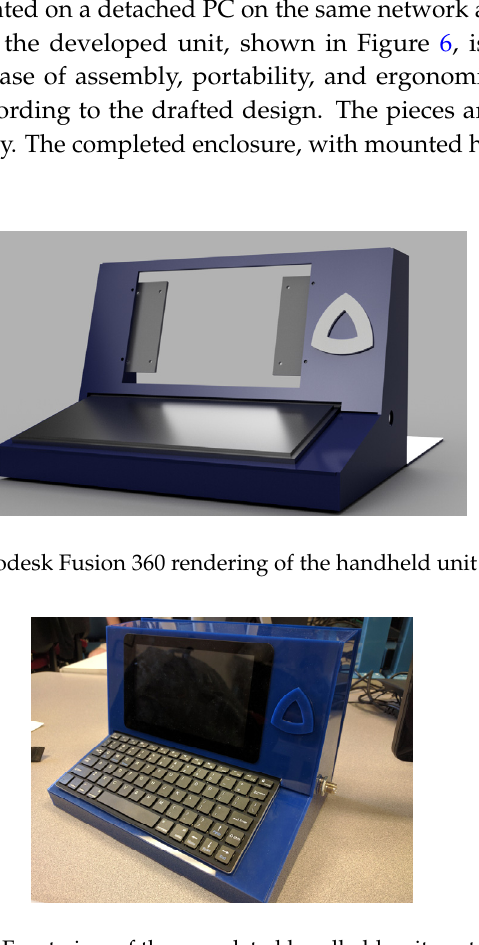
Figure 7. Front view of the completed handheld unit prototype.